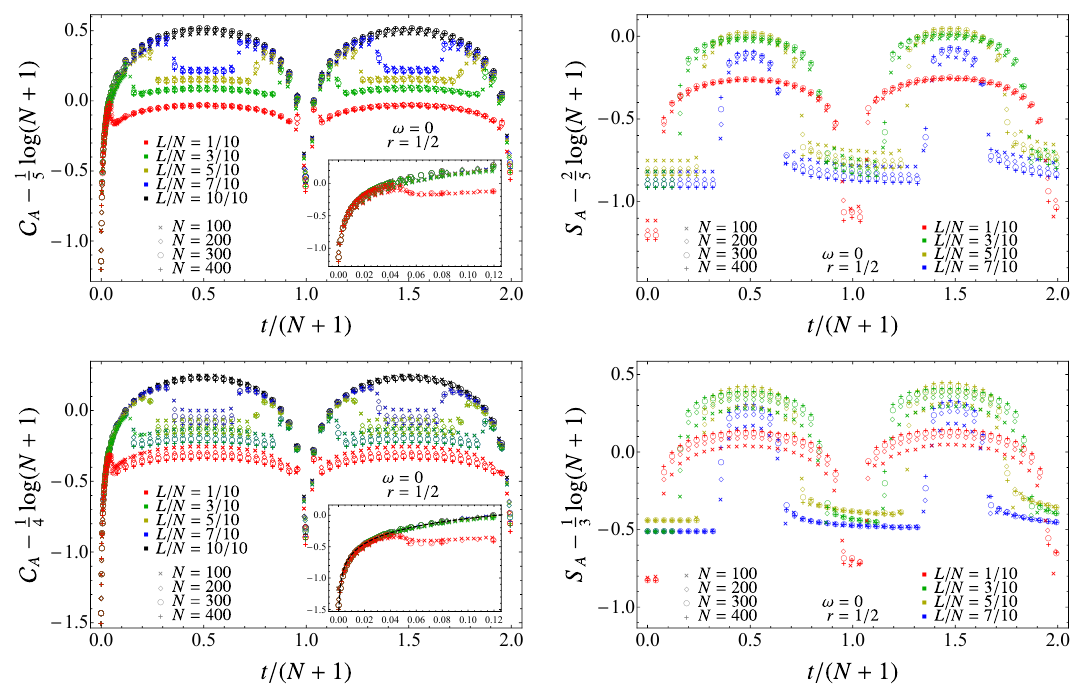
Figure 10 . Temporal evolution of the subsystem complexity C A (left panels) and entanglement entropy S A (right panels) for a block A made by L sites whose midpoint is given by the joining point at r = 1 / 2 (see figure 1, bottom right panel) after a local quench with ω = 0 . The insets zoom in on the initial growth (the dashed curve in the bottom left panel is given by